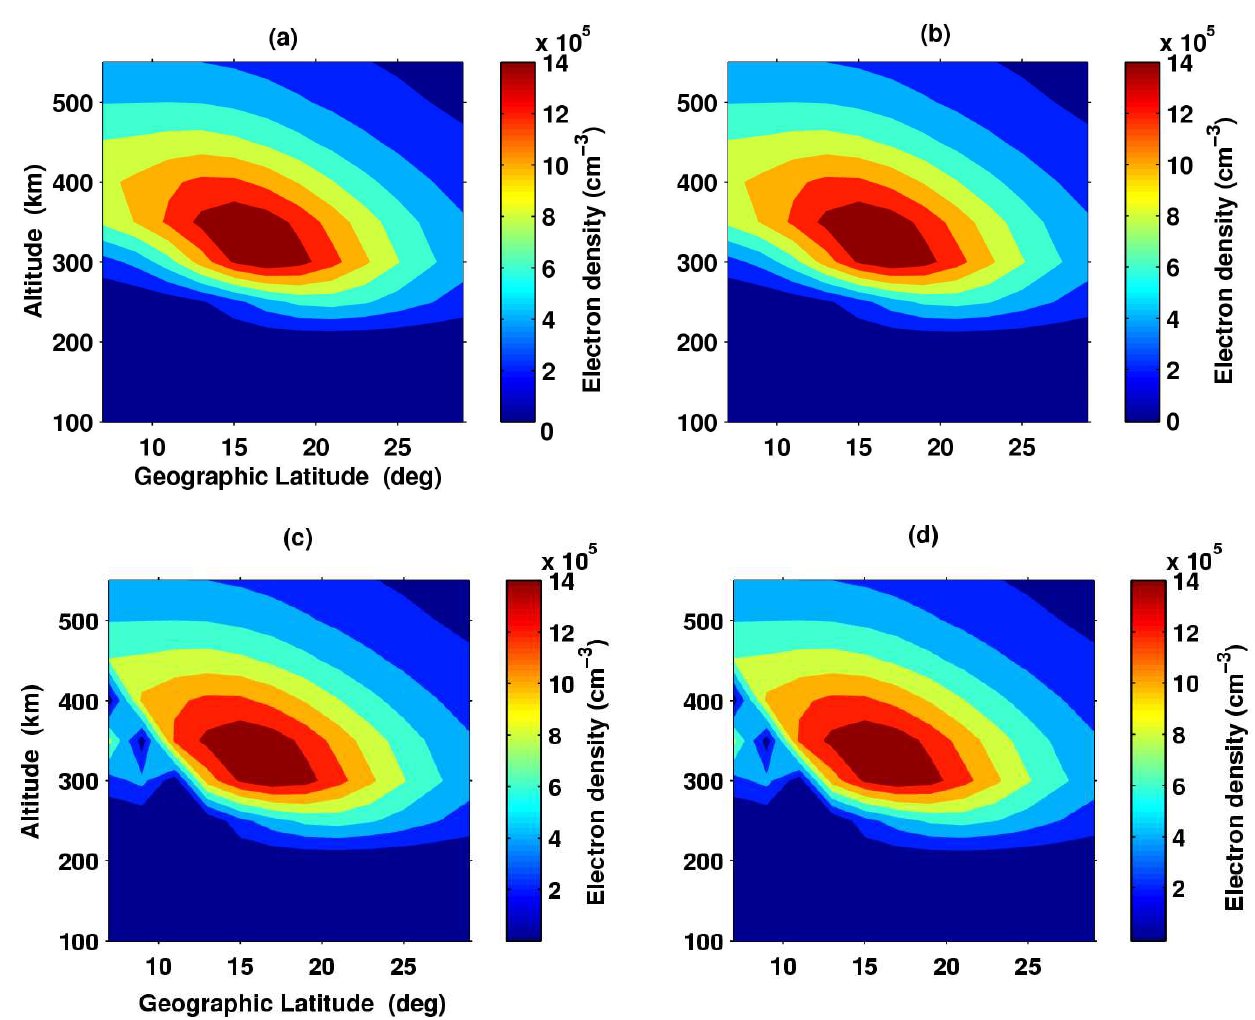
Fig. 6. ( a , b ) The applied model ionospheres with plasma bubbles at different altitudes. ( c , d ) The corresponding tomographic